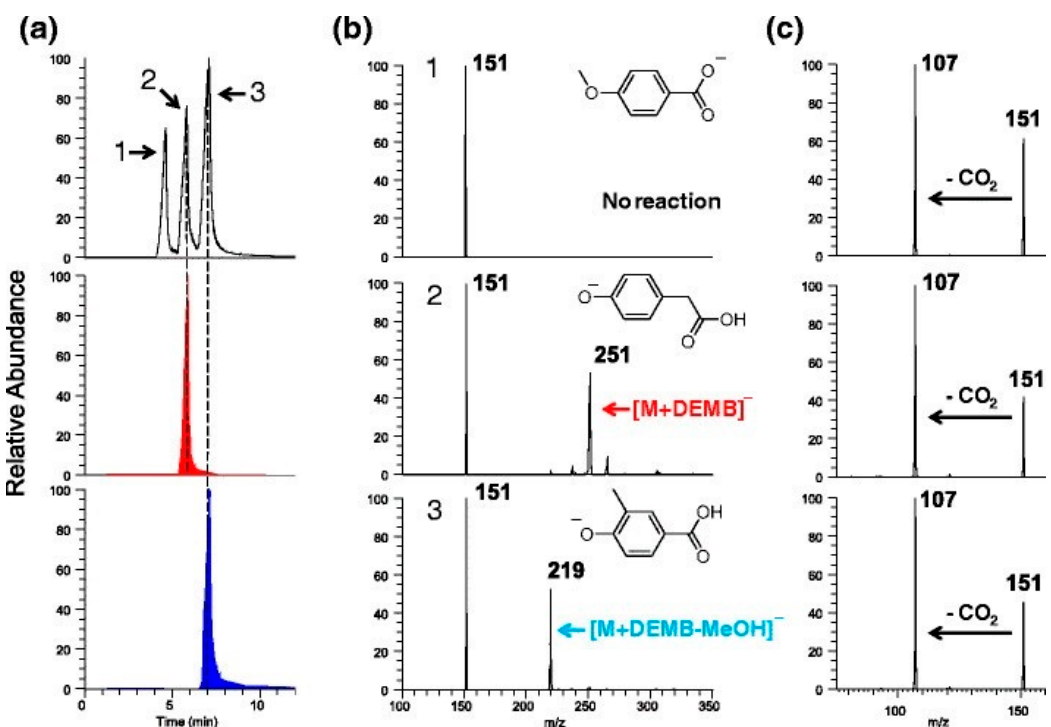
Figure 4. ( a ) (top) Total ion HPLC chromatogram measured for an equimolar mixture of 4-methoxybenzoic acid (1), 4-hydroxyphenylacetic acid (2), and 4-hydroxy-3-methylbenzoic acid (3). ( b ) MS 2 spectra measured after the reaction of 4-methoxybenzoic acid (top), 4-hydroxyphenacetic acid (middle), and 4-hydroxy-3-methylbenzoic acid (bottom) with diethylmethoxyborane. ( c ) Collision-induced dissociation (CID) spectra measured for 4-methoxybenzoic acid (top), 4-hydroxyphenacetic acid (middle), and 4-hydroxy-3-methylbenzoic acid (bottom). Reprinted from Zhu et al. with permission from the Springer Publishing [56].